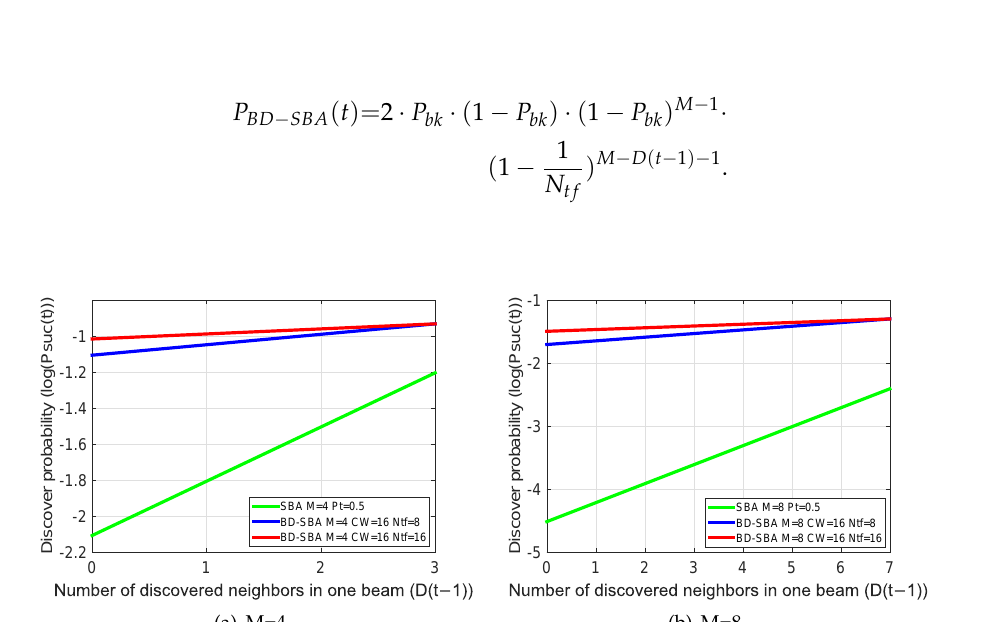
Figure 9. Comparison of discovery probability between SBA and BD-SBA